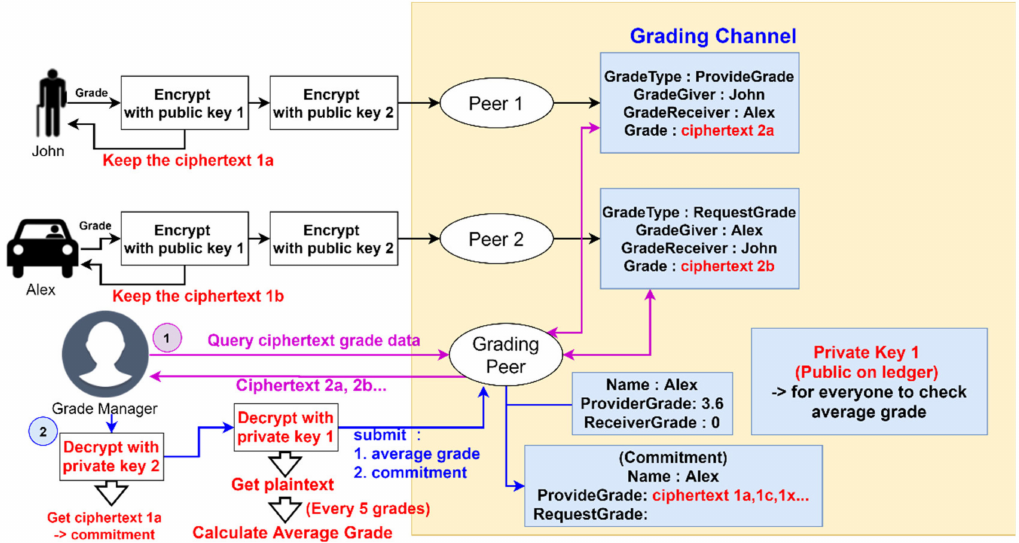
Figure 6. The information flow and the processes in the grading channel